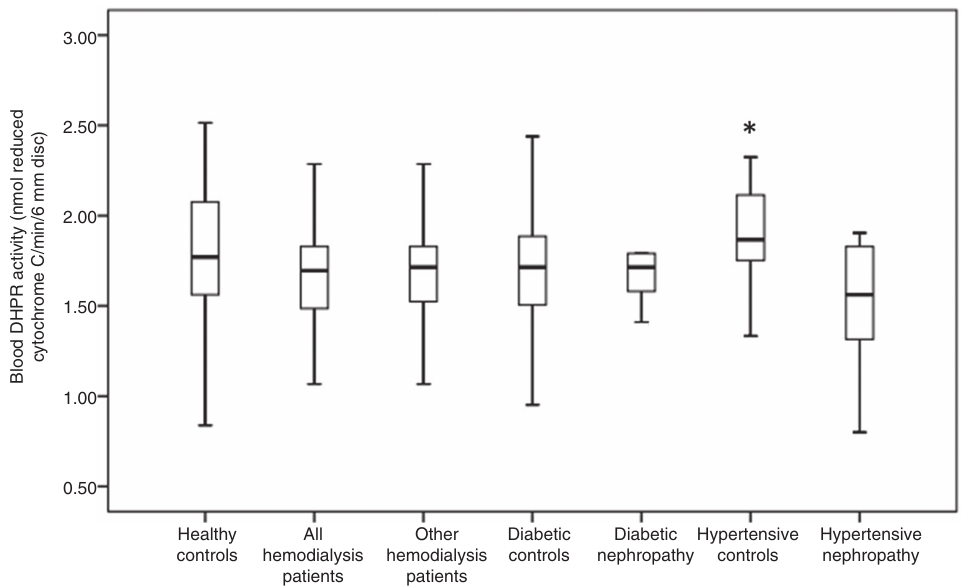
Figure 2 Box-plot graphs of blood DHPR activities in the control groups and patients undergoing hemodialysis. *p < 0.05, vs. hypertensive